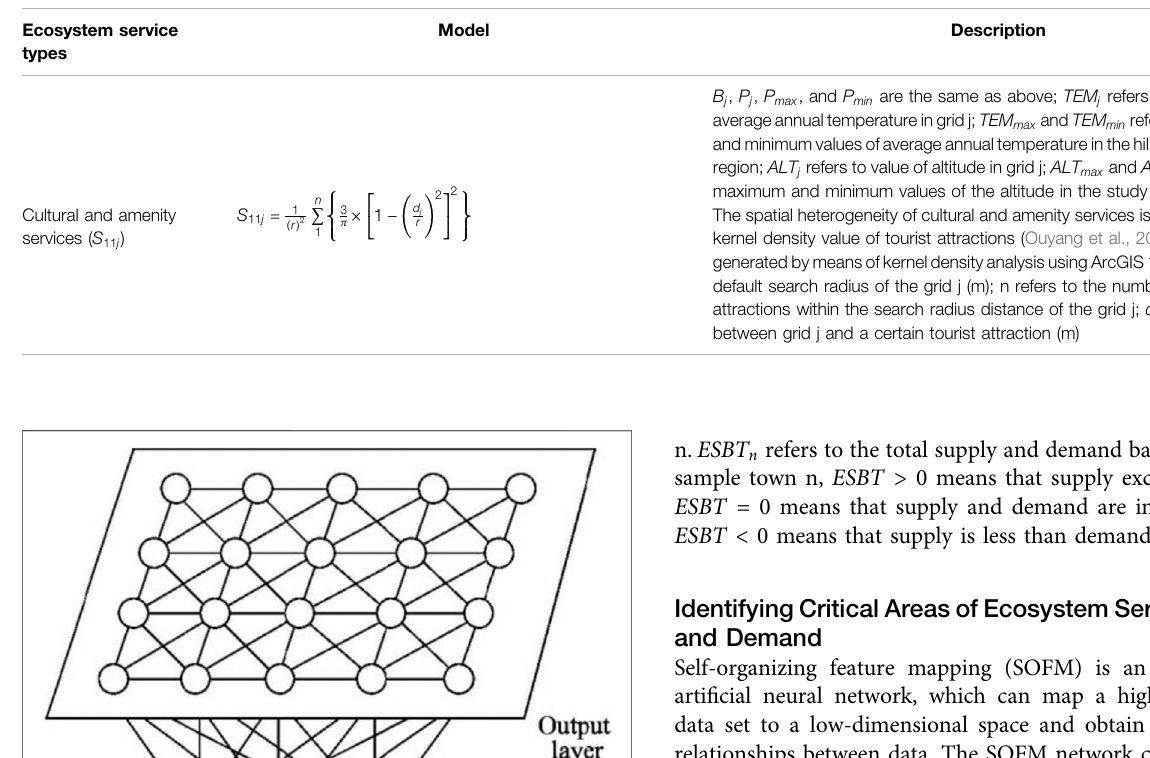
TABLE 2 | ( Continued ) Spatial heterogeneity index model of the supply of 11 ecosystem services.